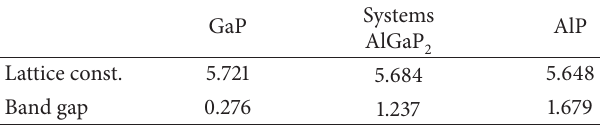
Table1:Equilibriumlatticeconstants(˚A)andbandgap(eV)forAlP, . GaP, and AlGaP 2